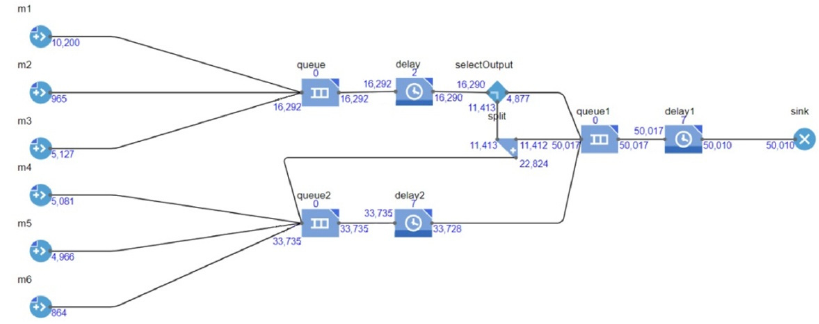
Figure 2. Simulation of a system with blockchain nodes.